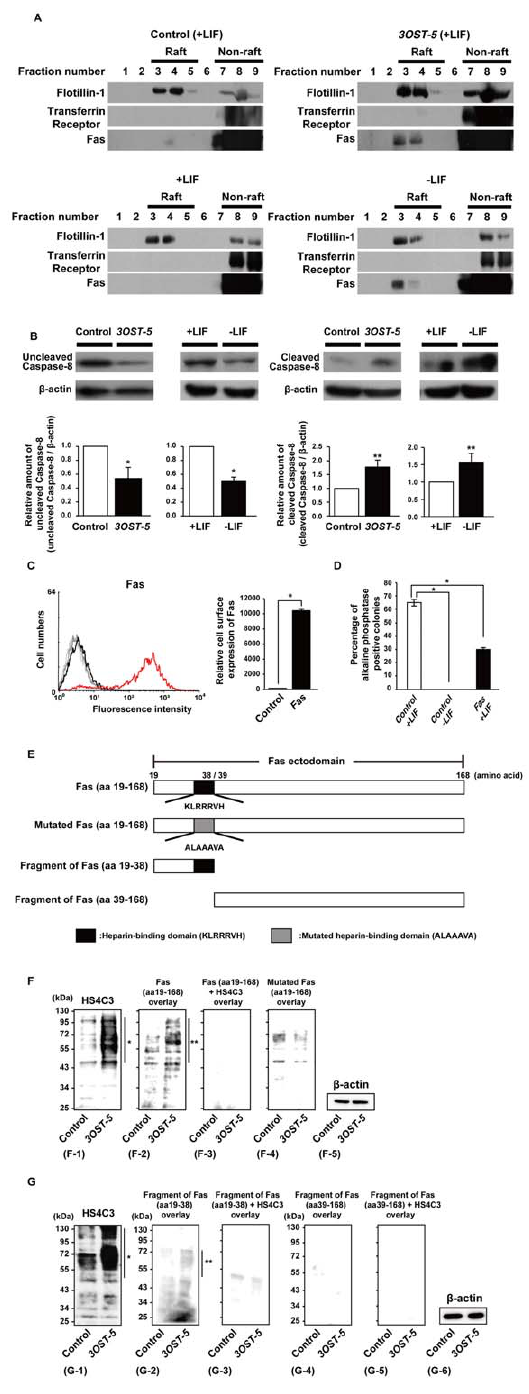
Figure 4. Fas signaling is activated by redistribution of Fas into lipid rafts in cells overexpressing 3OST-5 . (A) Western blot analysis of raft and non-raft fractions, using anti-Flotillin-1 (raft), anti-transferrin receptor (non-raft), and anti-Fas antibodies, of mESCs at 2 days after transfection with the 3OST-5 expression construct ( upper two panels ) or mESCs at 6 days after LIF withdrawal ( lower two panels ). At least two independent experiments were performed. Representative results are shown. (B) Western blot analysis, using antibodies against uncleaved and cleaved caspase-8, of mESCs at 2 days after transfection with the 3OST-5 expression construct ( left and middle right panels ) or mESCs at 8 days after LIF withdrawal ( middle left and right panels ). The histograms show mean densitometric readings 6 SD after normalization